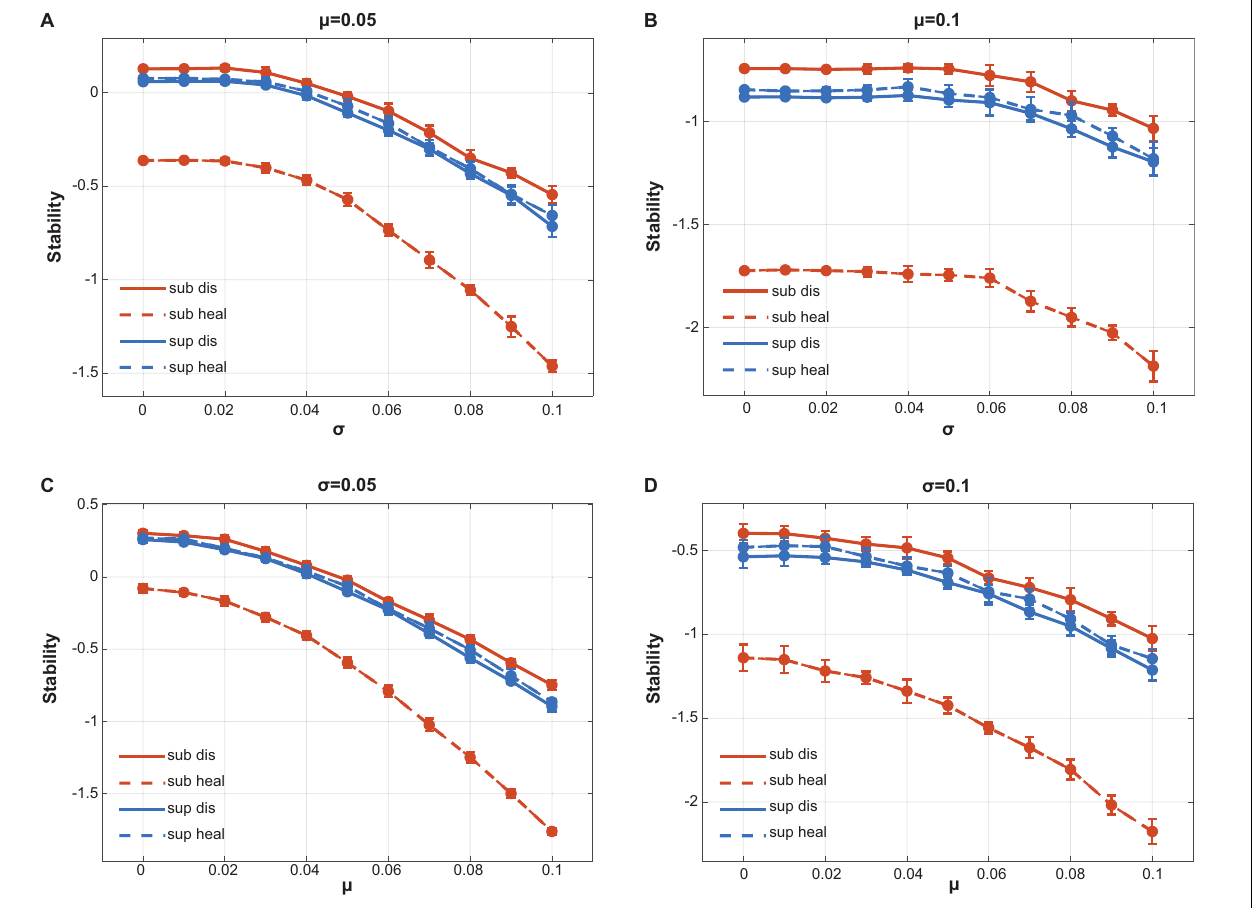
FIGURE 5 | Calculation of local stability. Red lines stood for supragingival communities while blue lines stood for subgingival communities. Healthy and diseased communities are shown in dotted and solid lines, respectively. Connectance, interacting species richness, and bacterial correlations were drawn directly from our interacting matrix. The strength of bacterial interactions was assigned to follow a normal distribution with mean µ and variance σ 2 . By changing the value of µ and σ , we performed a series of calculations to compare the stability of our communities (see also Supplementary Figure 3 ). (A) µ = 0.05 with variable σ . (B) µ = 0.1 with variable σ . (C) σ = 0.05 with variable µ . (D) σ = 0.1 with variable µ . All calculations showed the same tendency that the healthy subgingival communities had the worst local stability while the diseased subgingival communities had the highest. However, the stability difference in supragingival communities was not as distinct as that in subgingival